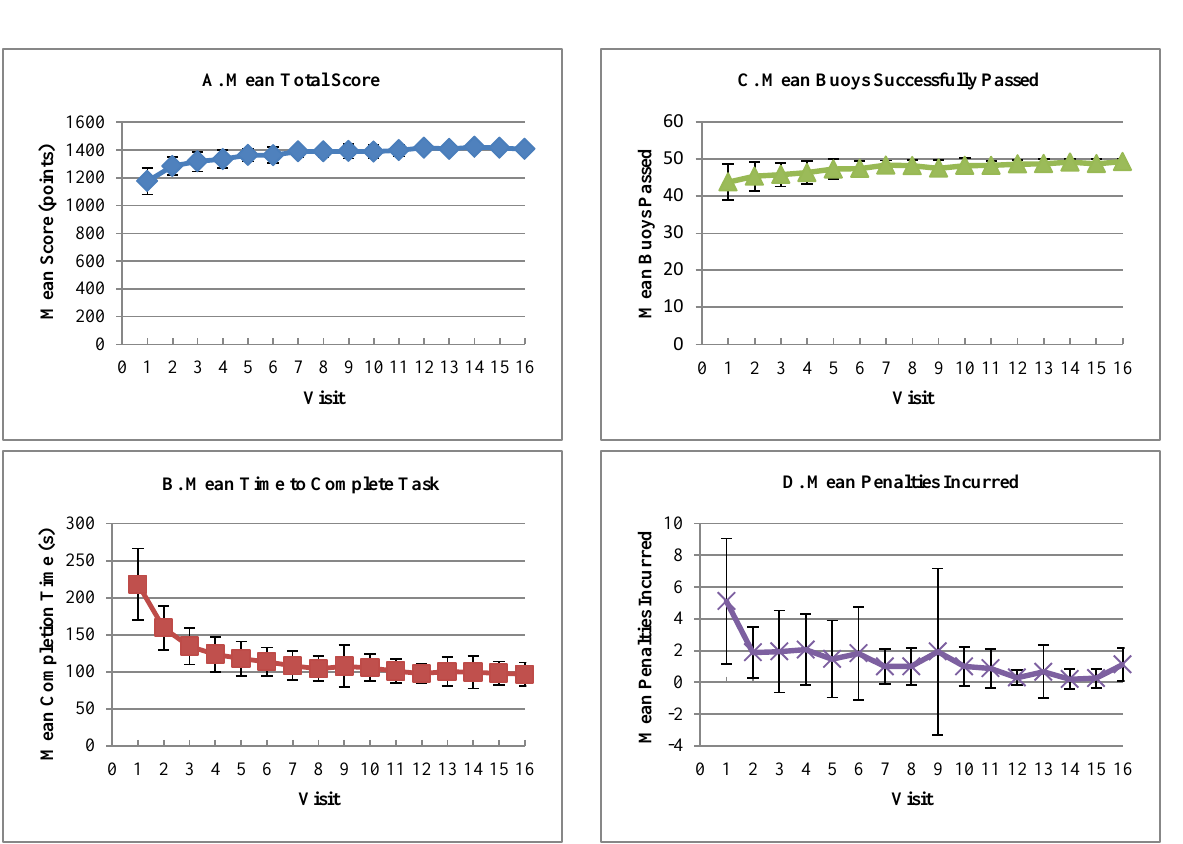
Figure 2 . Mean and standard deviations of total score (A), time to complete task (B), buoys passed (C), and penalties incurred (D) across the 16 visits. Follow-up visits at 3, 6, 9, and 12 months are labeled as Visit 13, 14, 15, and 16,